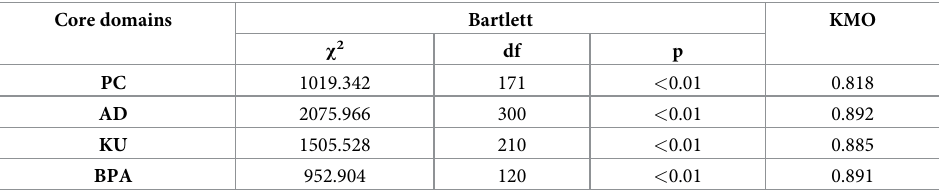
Table 6. Fitness test of factor analysis of physical literacy